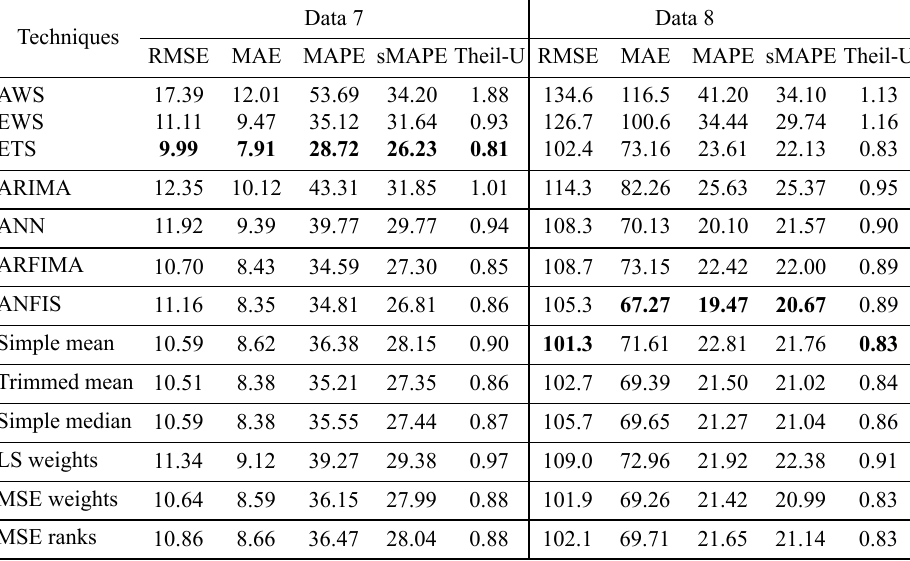
Table 7. Forecasting results of the single models and combining methods for Data 7 and 8 Data 7 Data 8 Techniques